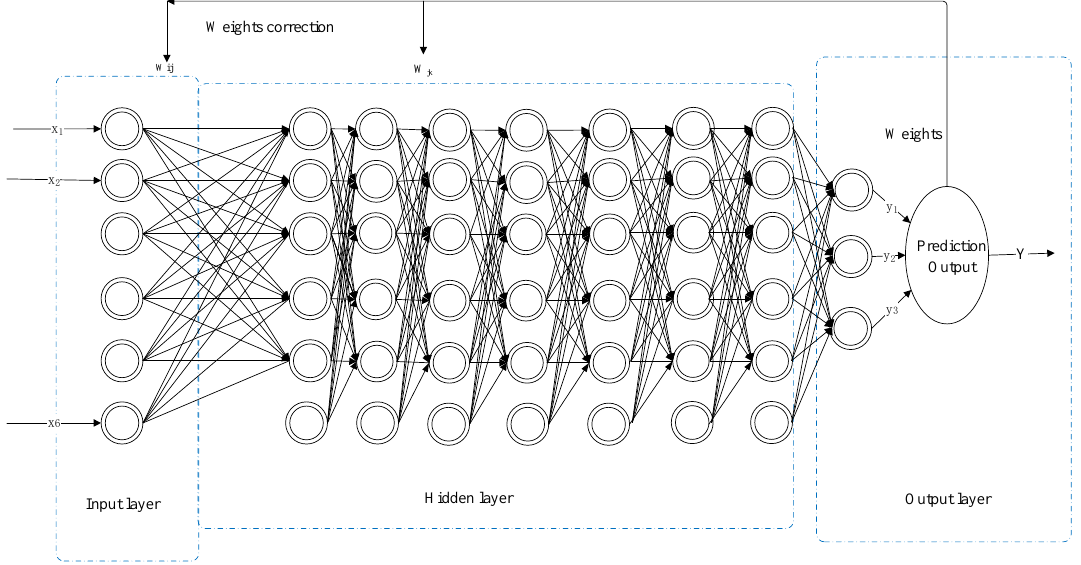
Figure 4. The structure of a deep neural network.